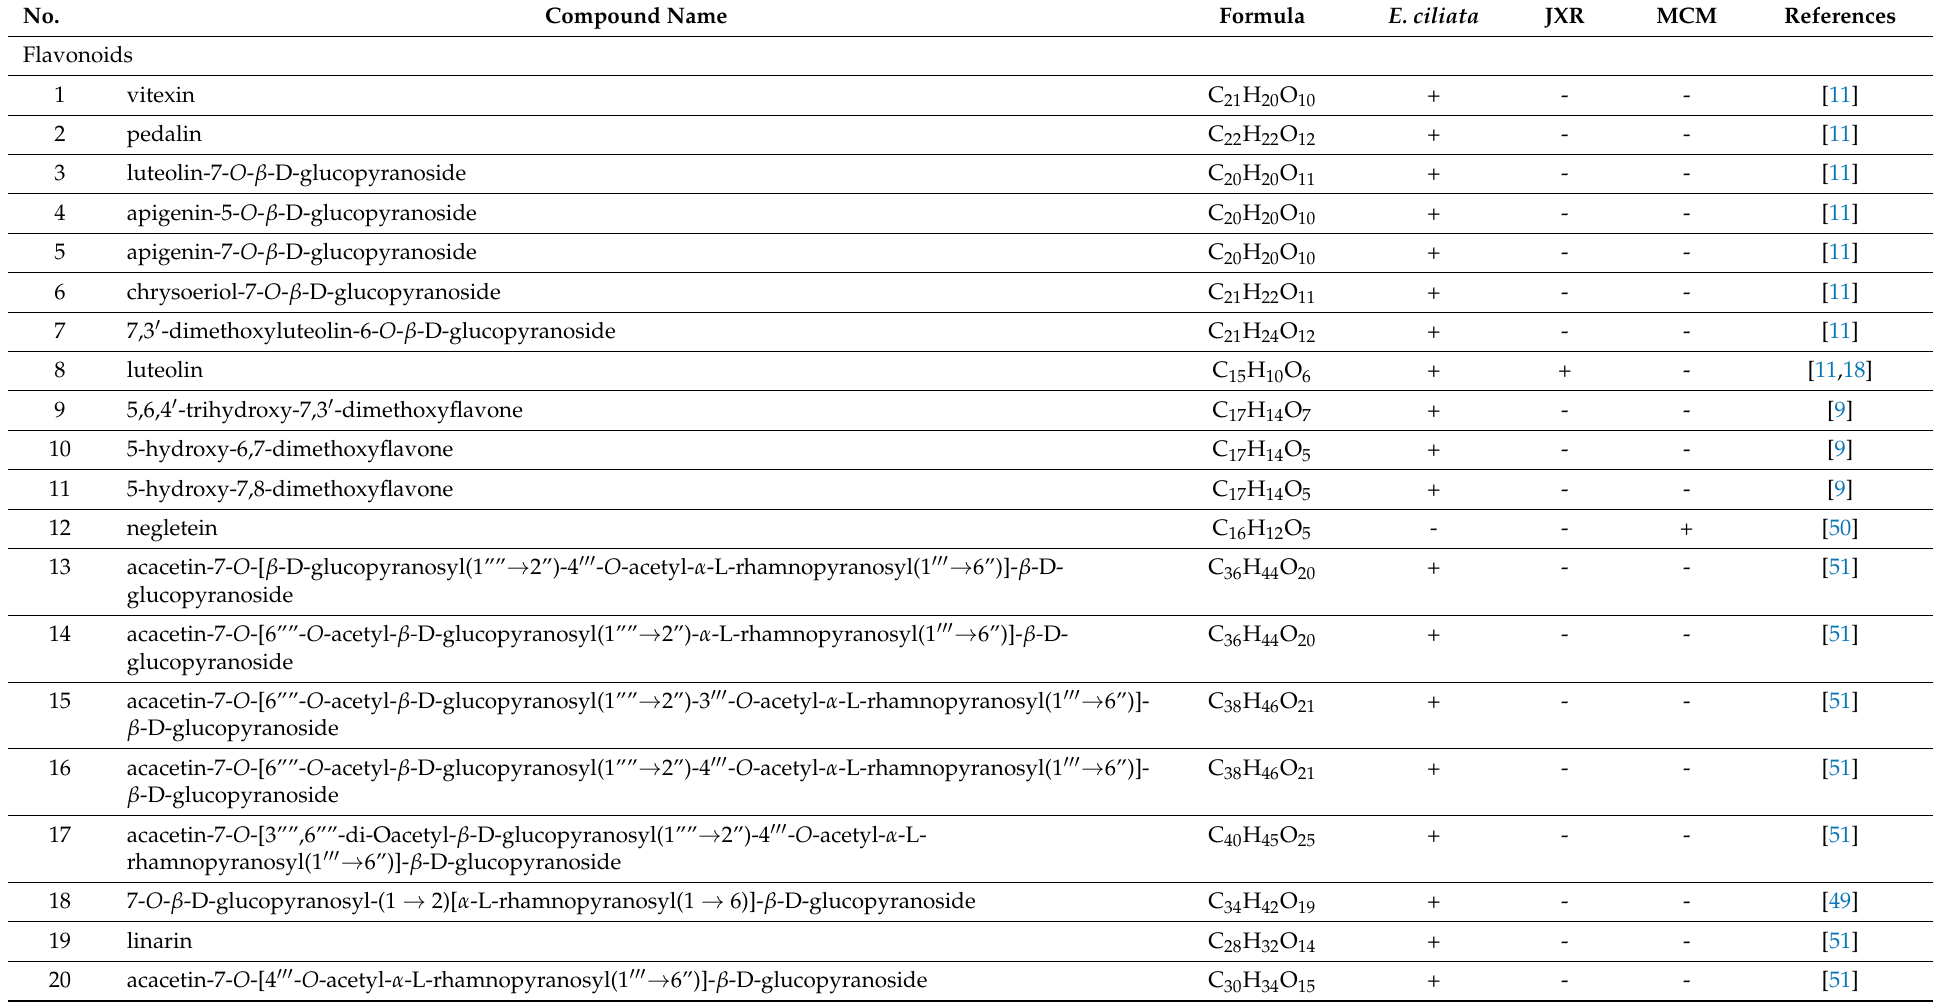
Table 1. Compounds